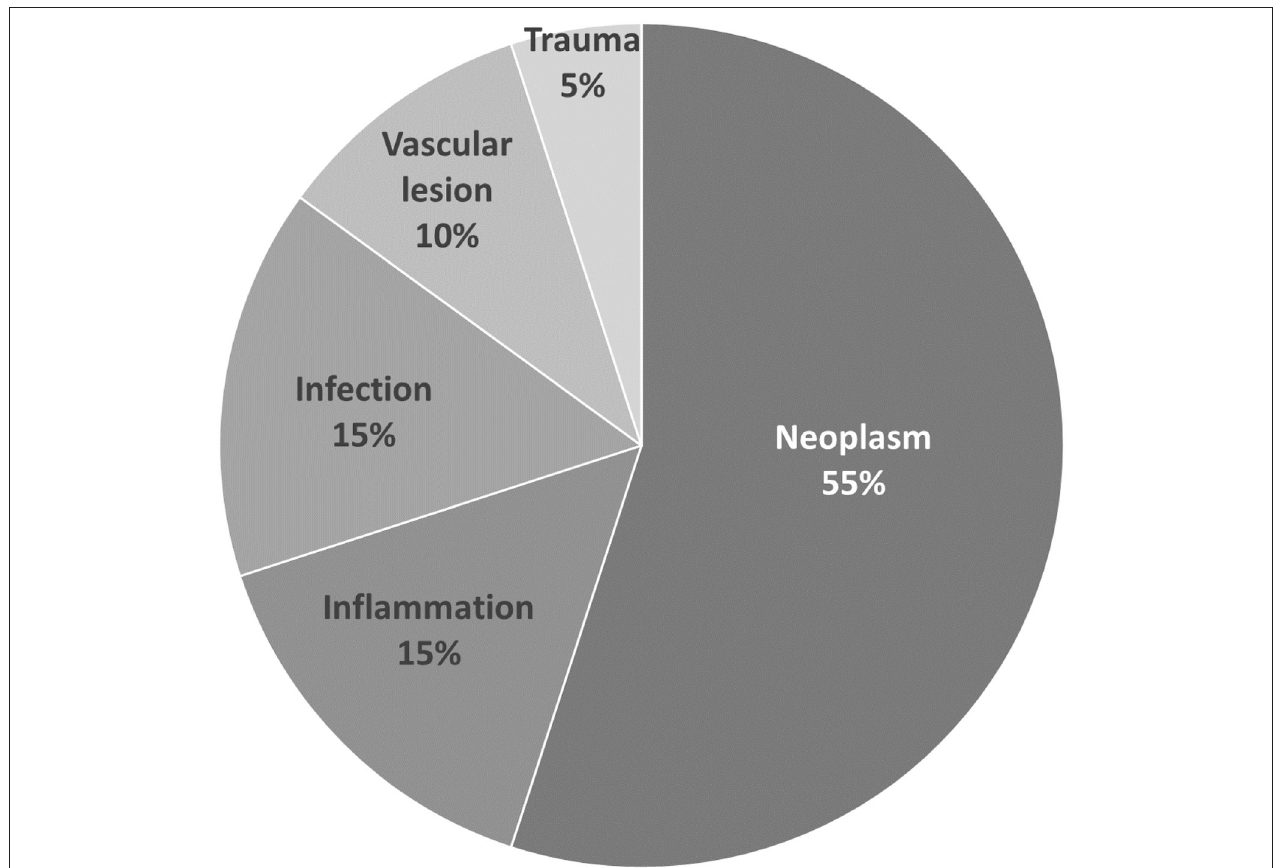
FIGURE 1 | Etiology of orbital apex